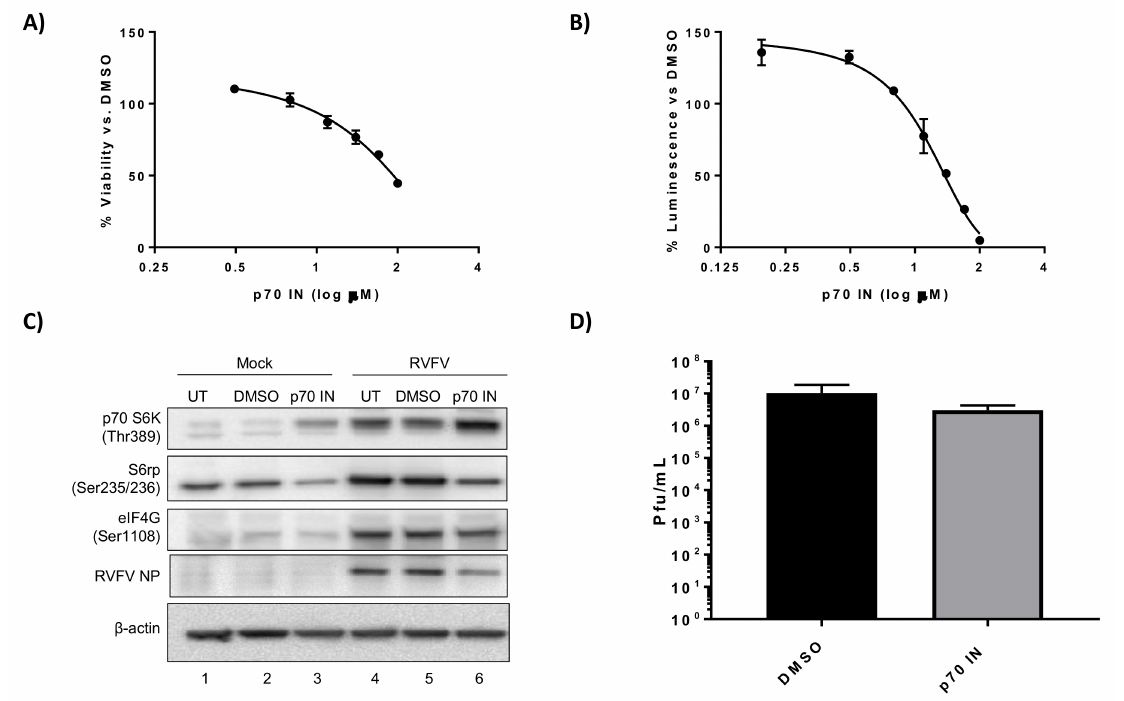
Figure 1. PF-4708671, a p70 S6K inhibitor, decreases RVFV N protein (NP) translation and